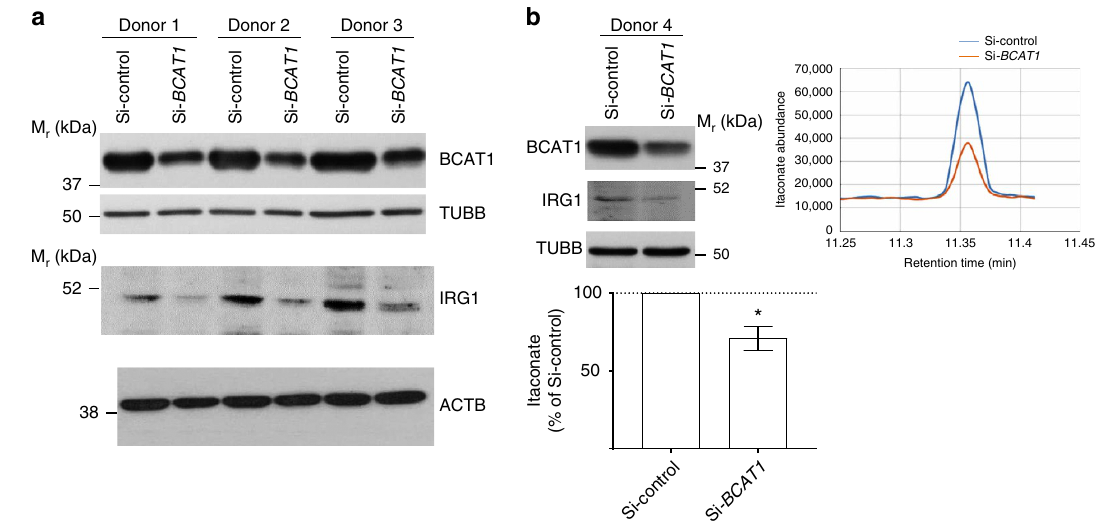
Figure 3 | BCAT1 silencing leads to reduced IRG1 and itaconate levels in activated human macrophages. ( a ) Western Blot following BCAT1 (Si- BCAT1 ) and non-targeting (Si-Control) siRNA treatment in hMDMs stimulated with LPS (100ngml (cid:2) 1 , 8h). BCAT1, IRG1, TUBB and ACTB blots are shown on three independent donor hMDMs. ( b ) BCAT1 and IRG1 Western Blot on Si- BCAT1 and Si-Control hMDMs from donor four and corresponding itaconate levels measured by GC/MS are shown in the right panel. Itaconate levels measured by GC/MS were further confirmed in si-BCAT1 and si-Control hMDMs from independent donors ( n ¼ 4, lower panel). Error bars are s.e.m. Significance was tested using one sample t -test (two-tailed). * P o 0.05 by one-sample- t